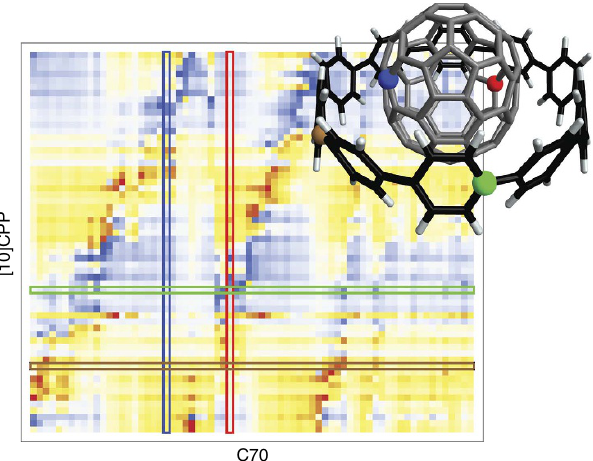
Figure 3 | Heat map of the xy component of the interfragment non-local polarizability a xy in [10]CPP–C70. Red and blue represent positive and AB negative values, respectively. Rows and columns correspond to carbon atoms of [10]CPP and C70, respectively, with four select carbon atoms color-coded to the marked atoms in the structure in the